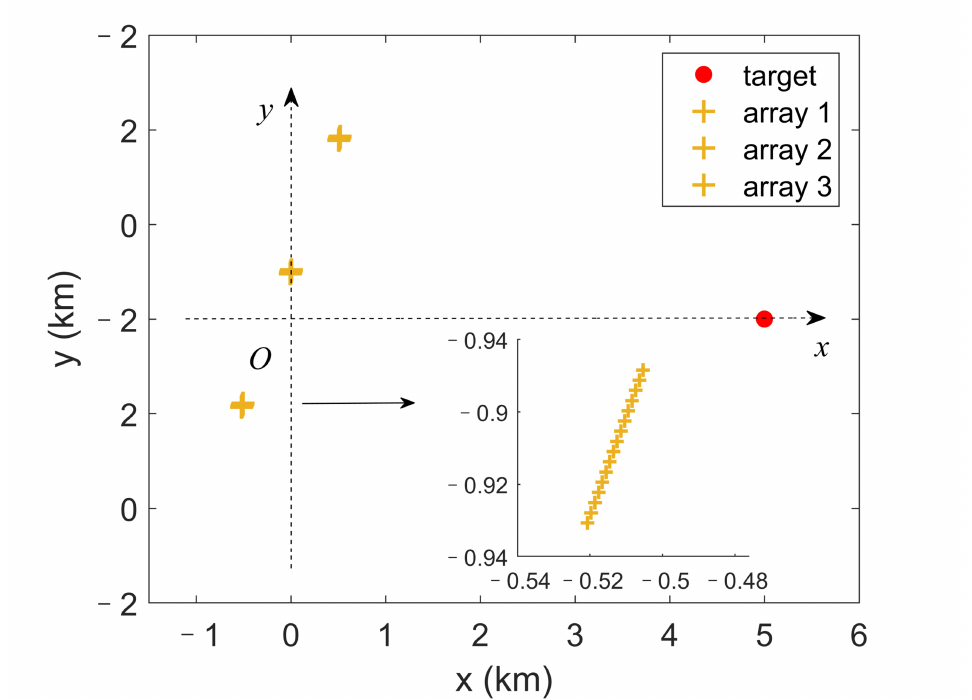
Figure 3. (Color online) Geometric plot of the receiving